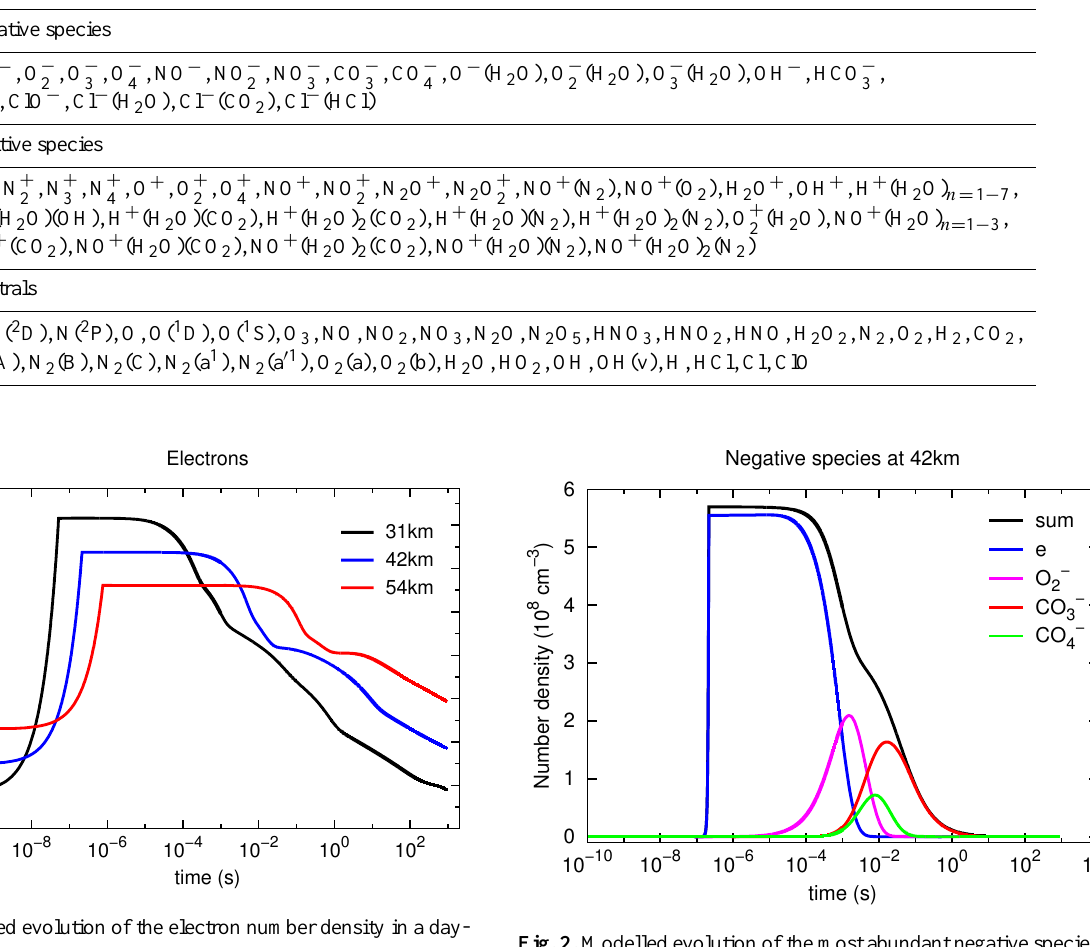
Fig. 2. Modelled evolution of the most abundant negative species in a daytime sprite streamer at 42km